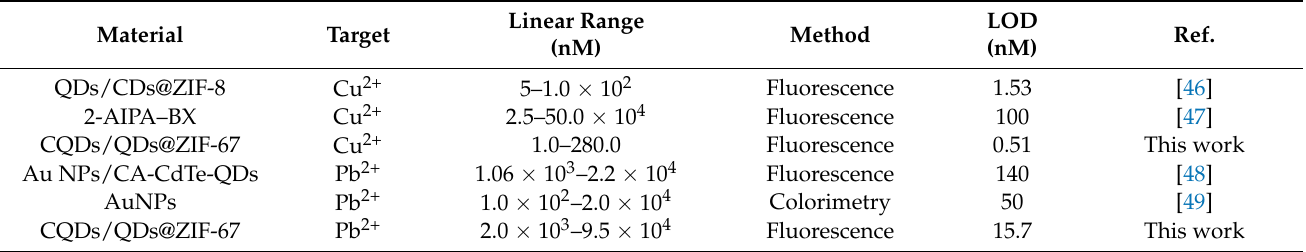
Table 1. Comparison of the detection performance of the proposed integrated sensor with those of existing optical sensors for Cu 2+ and Pb 2+